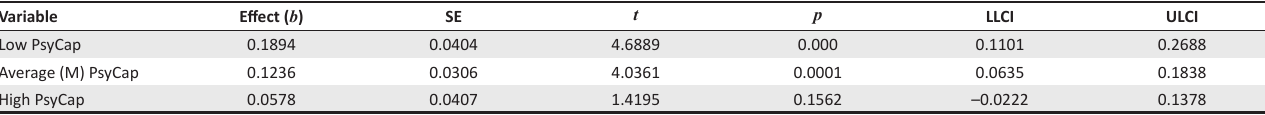
Effect (b), unstandardised simple slope; SE, standard error; t , t -statistic; p , p -value; LLCI, lower level confidence interval; ULCI, upper level confidence interval; M, mean; PsyCap, psychological capital.